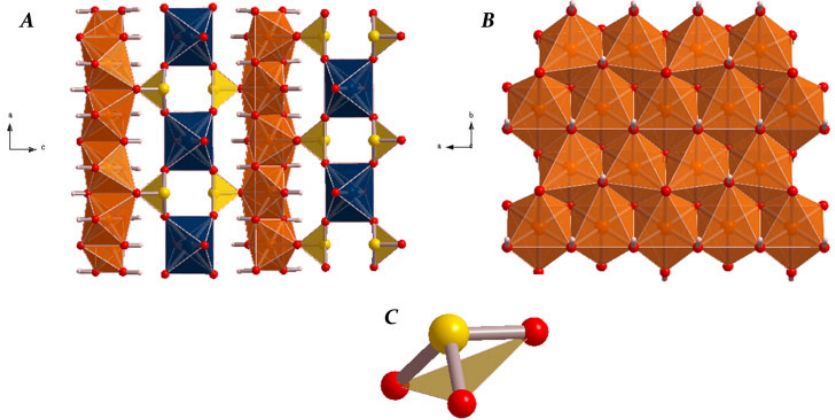
Figure 7. Structure of mineral derriksite: ( A ) view of the full unit cell from [0 1 0]; ( B ) copper octahedral layer; ( C ) selenium trigonal pyramids. Color code: U—blue; Cu—orange; Se—yellow; O—red; H—white.